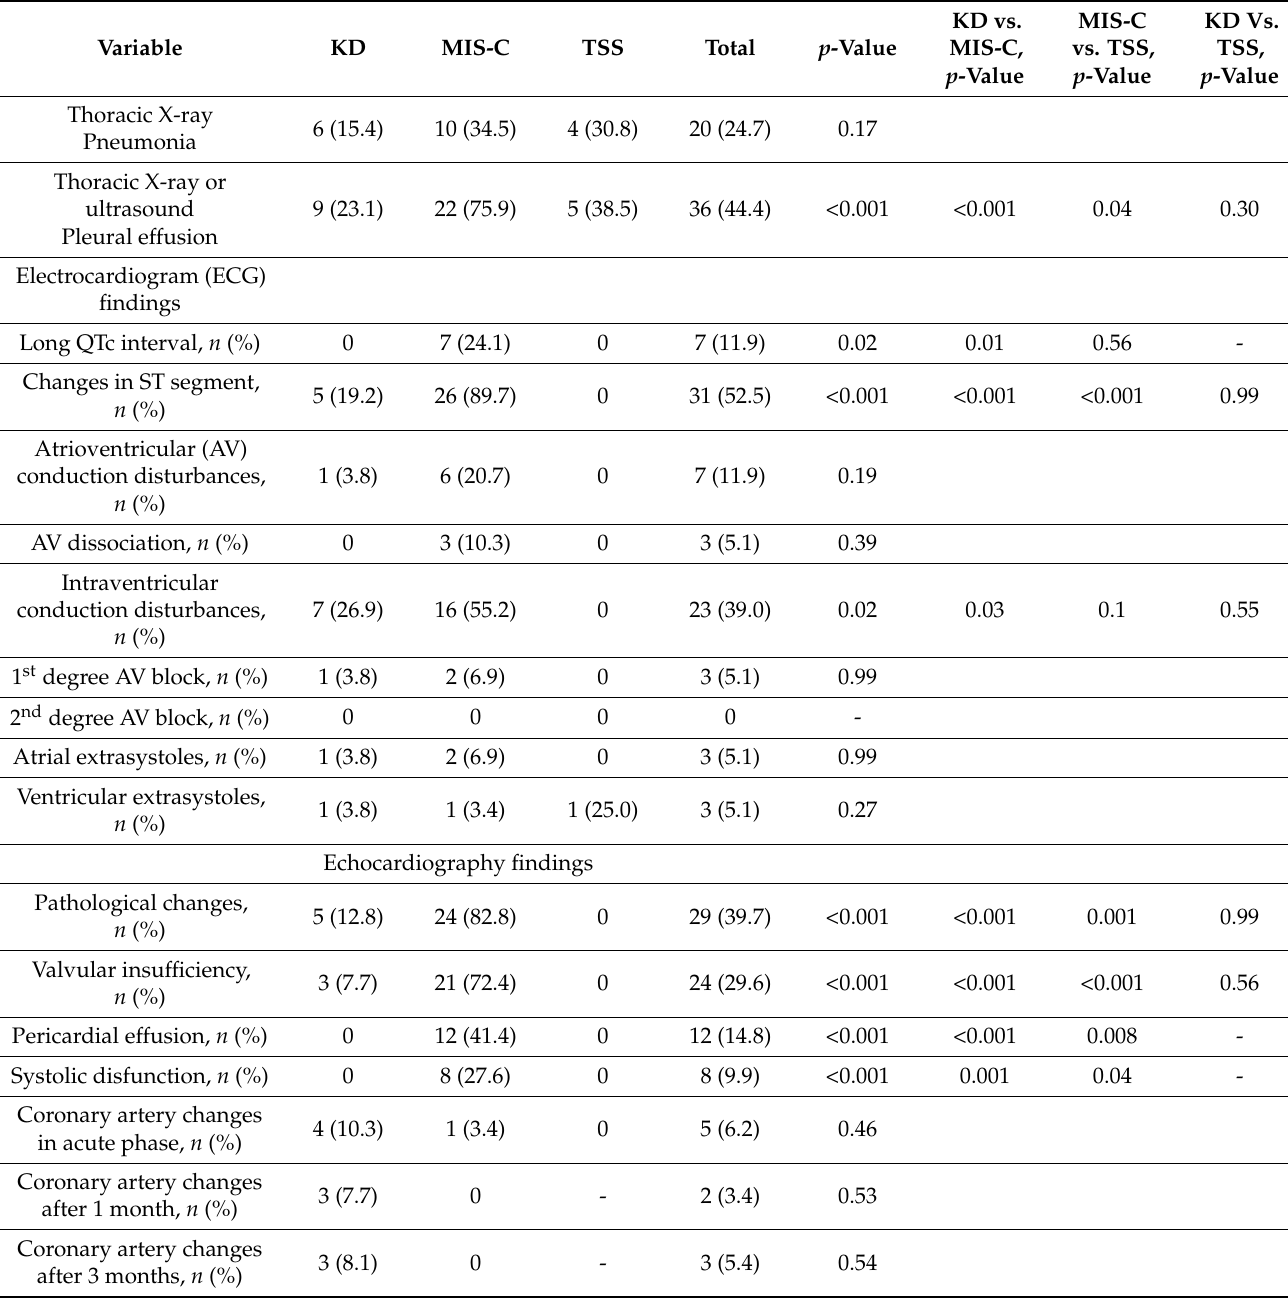
Table 3. Comparison of findings in instrumental diagnostic investigations and other diagnostic tests across study